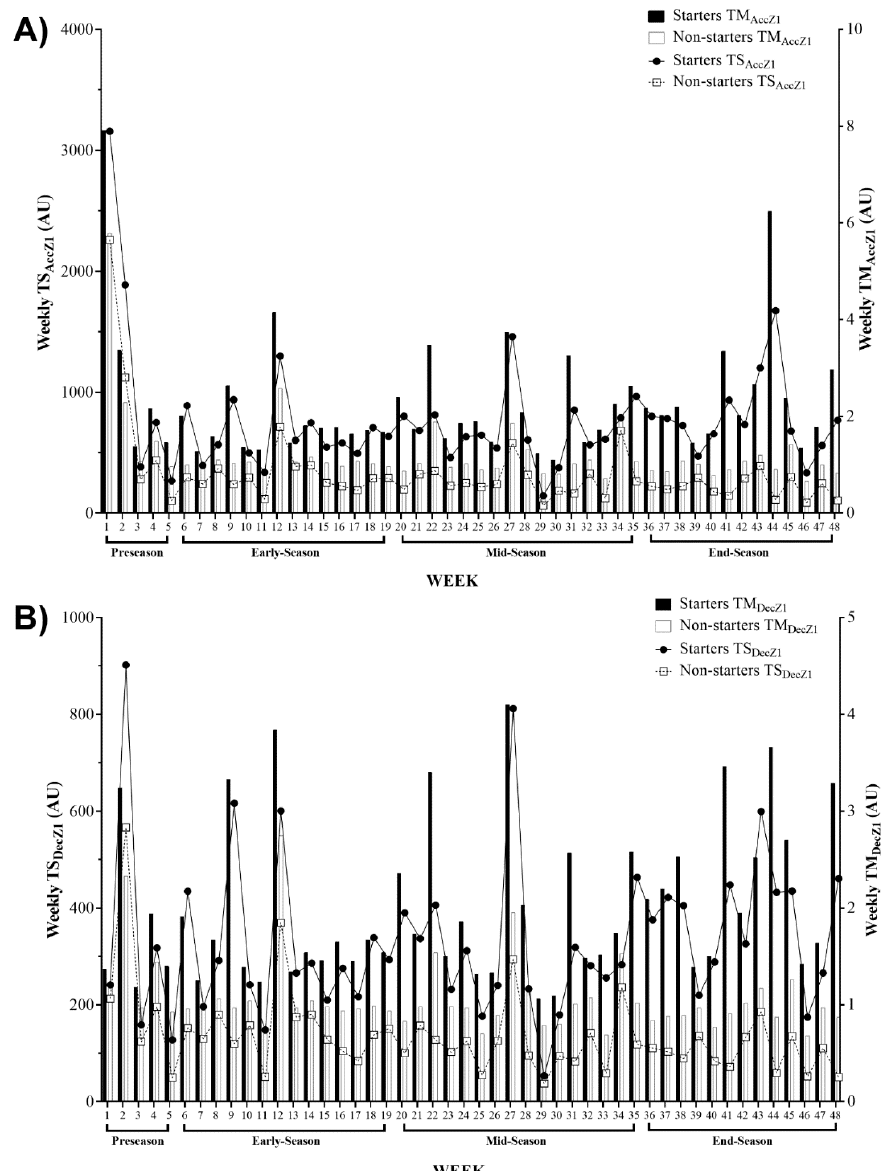
Figure 1. Descriptive statistics of weekly average for training monotony and training strain and their variations across the full season based on ( A ) number of accelerations in zone 1 ( < 2 m · s − 2 ) and ( B ) number of decelerations in zone 1 ( > − 2 m · s − 2 ). AU, arbitrary units; TM AccZ1 , weekly training monotony based on number of accelerations in zone 1 ( < 2 m · s − 2 ); TS AccZ1 , weekly training strain based on number of accelerations in zone 1 ( < 2 m · s − 2 ); TM DecZ1 , weekly training monotony based on number of decelerations in zone 1 ( > − 2 m · s − 2 ); TS DecZ1 , weekly training strain based on number of decelerations in zone 1 ( > − 2 m · s − 2 ).